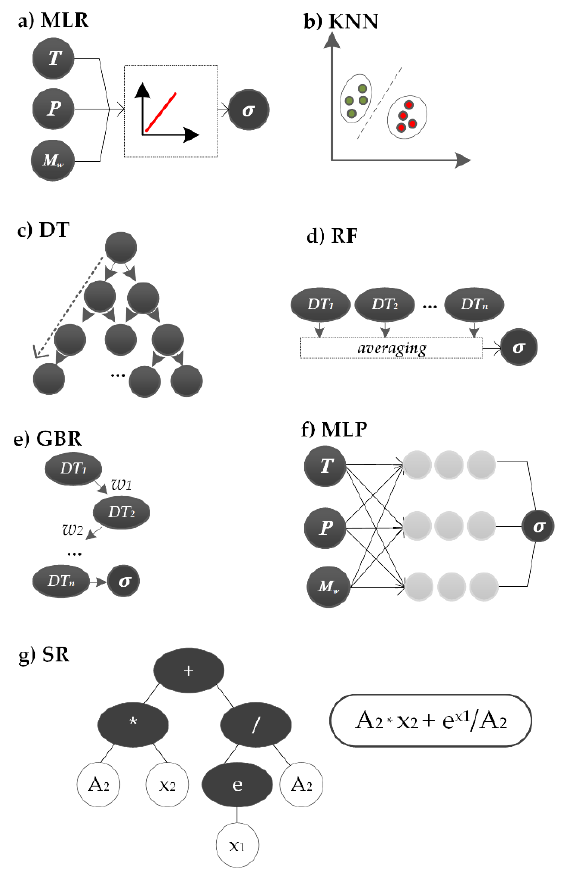
Figure 4 . Graphical implementation of ML algorithms incorporated in this paper: ( a ) multiple linear regression; ( b ) k-nearest neighbors; ( c ) decision tree, ( d ) random forest; ( e ) gradient boosting regressor; ( f ) multi-layer perceptron; ( g ) symbolic regression.